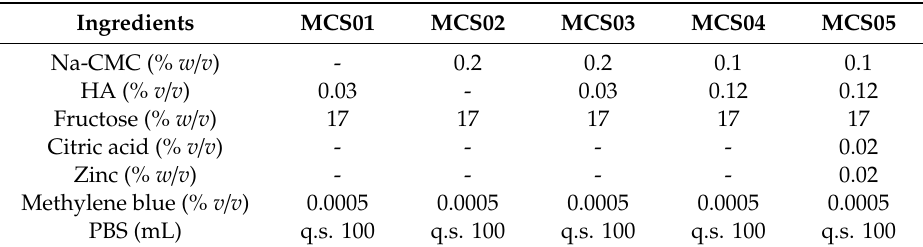
Table 1. Compositions (% w / v ) of polymeric solution